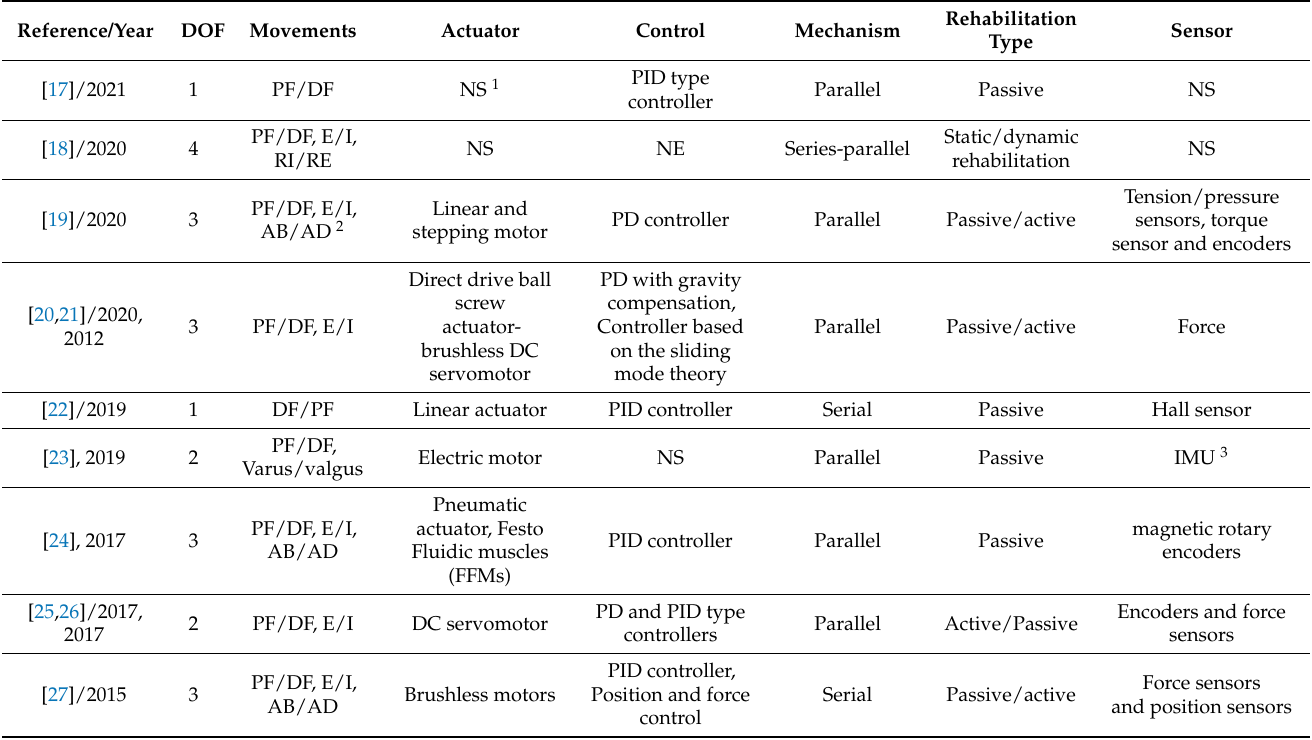
Table 1. State-of-the-art ankle rehabilitation